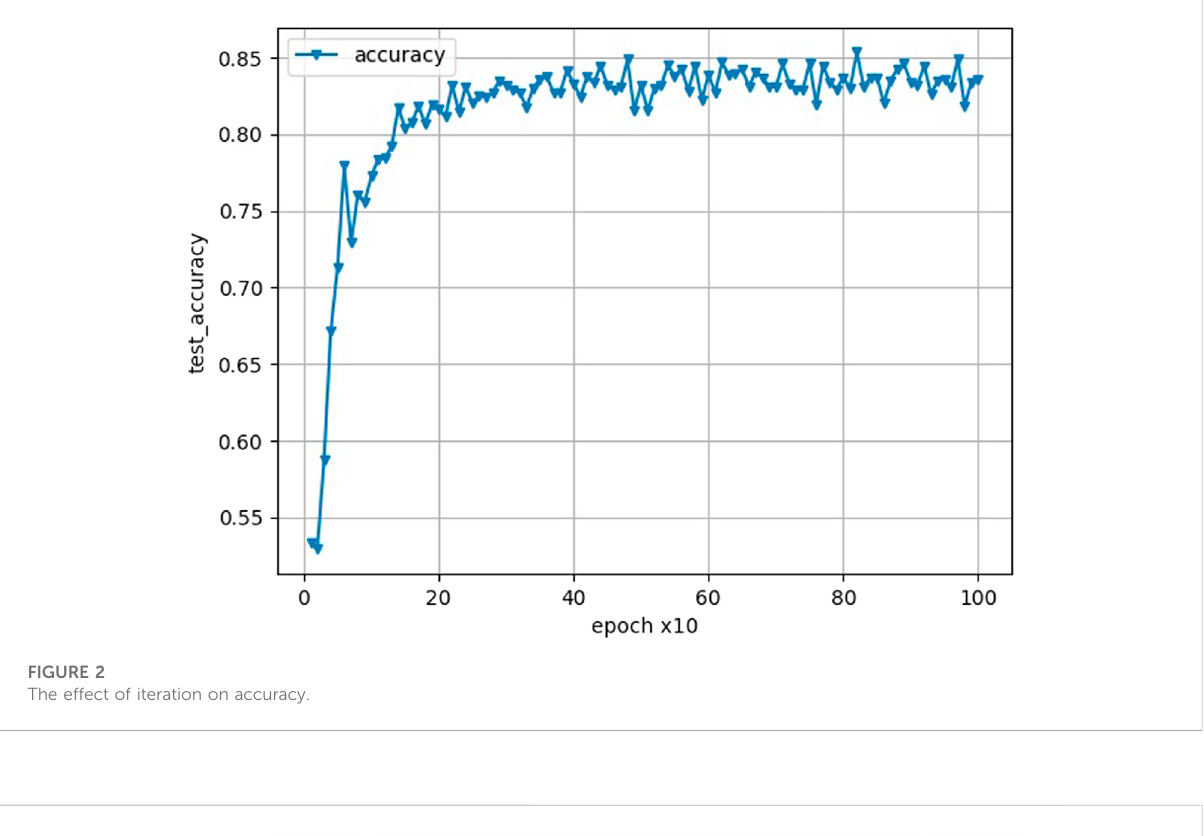
FIGURE 2 The effect of iteration on accuracy.